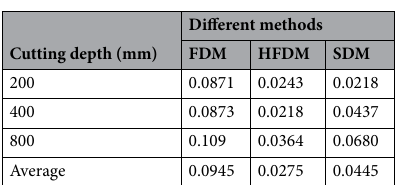
Table 2. RMSE between different methods.